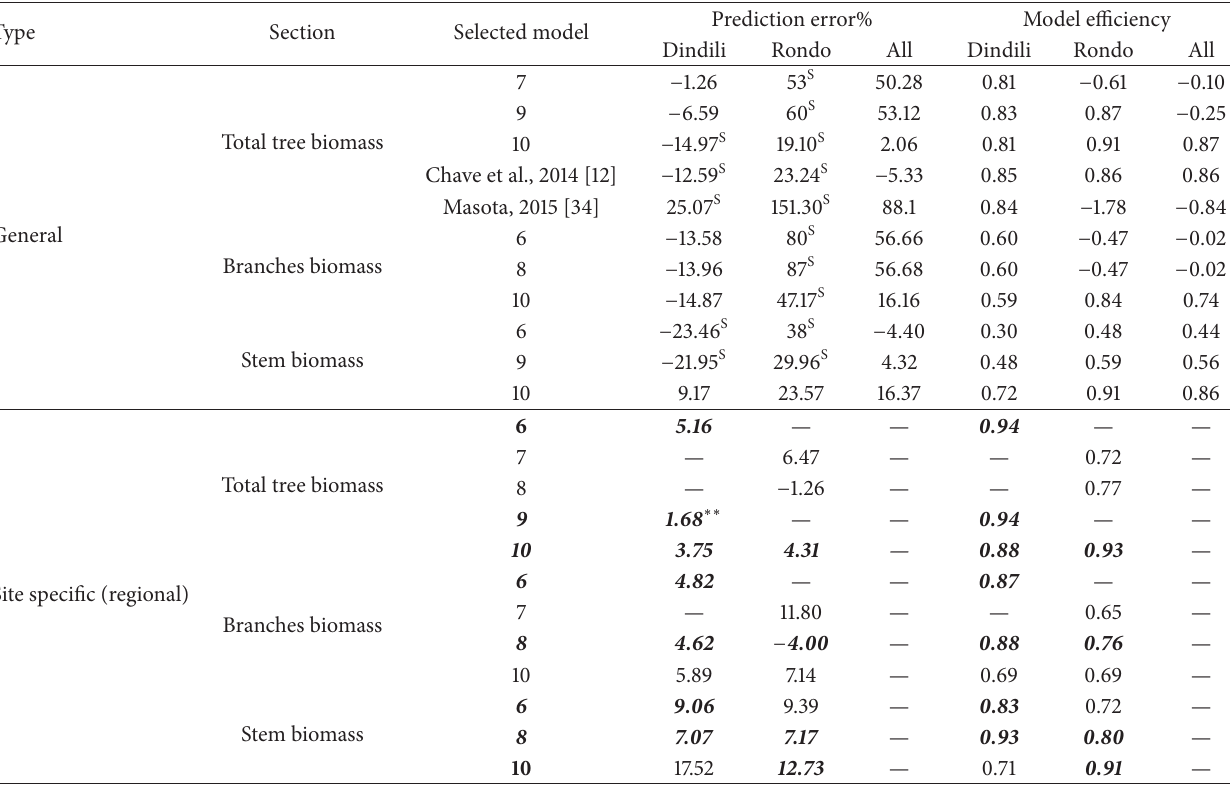
Table 7: Evaluation of the selected general and site specific models for tree total, branches, and stem biomass. Type